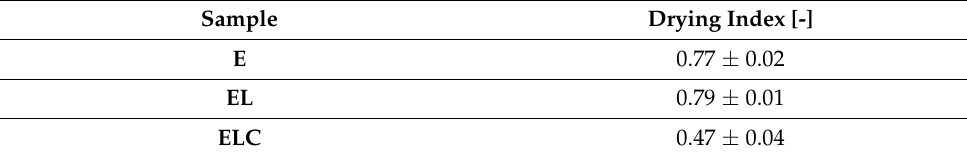
Table 5. Results of drying test (drying